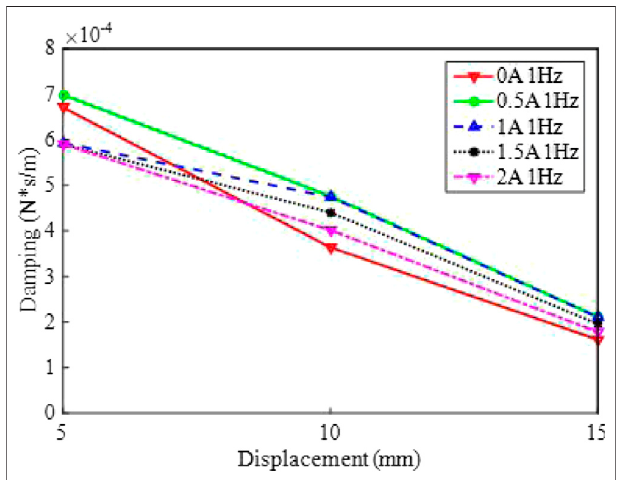
FIGURE 11 | The equivalent damping of the MR seat suspension under different excitation amplitudes.